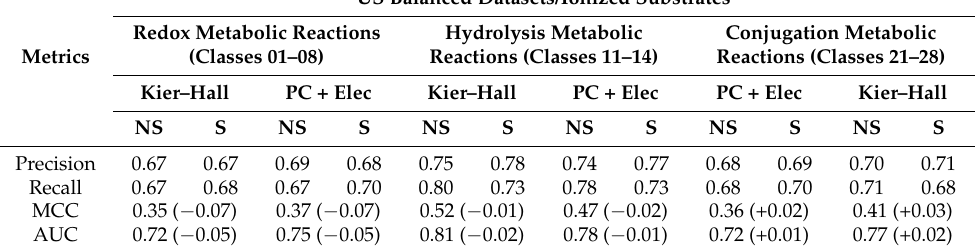
Table 2. Performance of the developed predictive models for the three major classes of metabolic reactions when considering ionized substrates. Based on the previous results, the predictive analyses focused on the balanced datasets and two sets of descriptors were considered (physicochemical plus stereo-electronic descriptors and Kier–Hall topological indices). In parentheses, the differences with the metrics reported in Table 1.